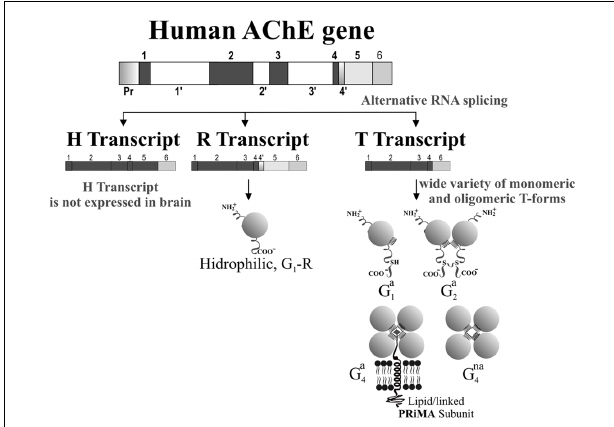
FIGURE 4 | Diagram of the humanAChE gene structure, its alternative splicing and generation of variants and molecular forms ofAChE in brain. Gene structure showing the splicing pattern of the six major exons. The catalytic core of human AChE is encoded by three exons and additional exons encode the variant-specific carboxy-terminal sequences. In the normal human brain, much more AChE-T than AChE-R mRNA is produced. However, under stress AChE-R expression is increased.To date, no expression of AChE-H has been described in the brain (see Grisaru et